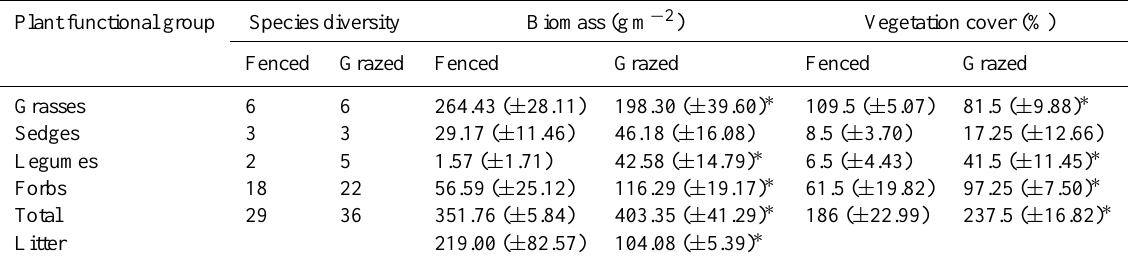
Table 1. Species diversity, mean ( ± SD – standard deviation) vegetation aboveground biomass, and vegetation cover in the fenced and control grazed